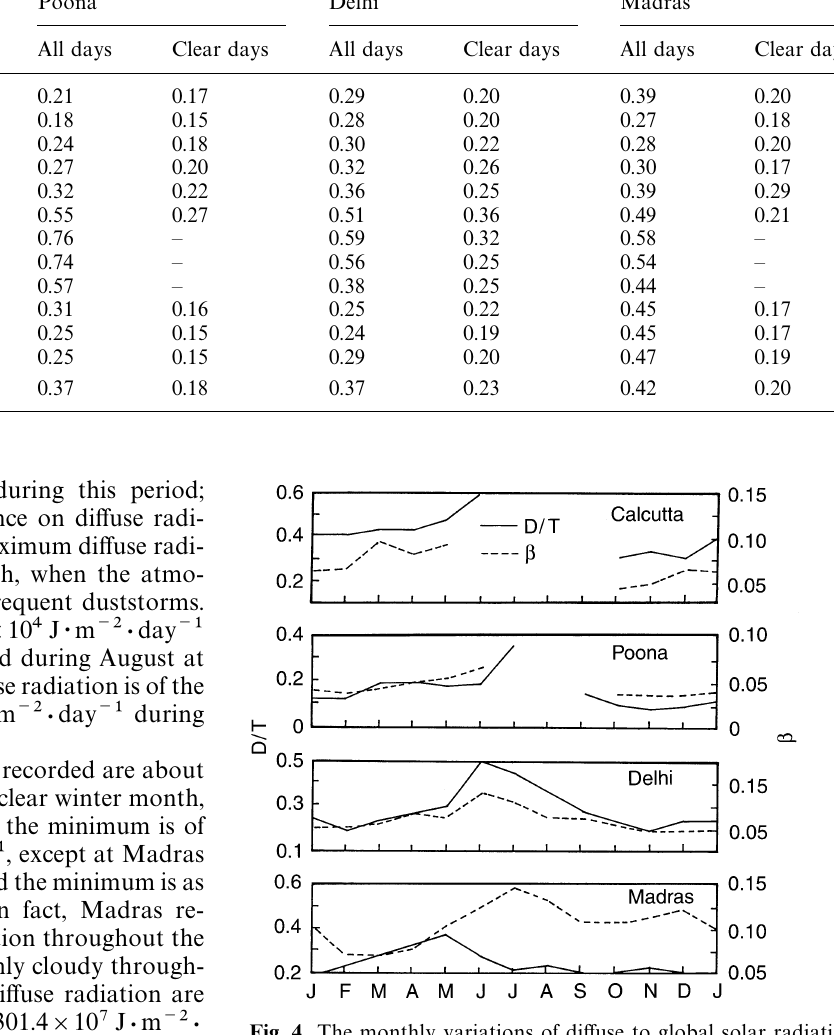
The mean daily values of the ratios of diffuse to global solar radiation ( D / „ ) for clear days and the mean daily values of the Angstrom turbidity coefficient ( (cid:98) ) for the four stations are plotted in Fig. 4. The coefficient (cid:98) is defined as the extinction due to scattering and absorption of aerosols. On a clear day one may expect D / „ to depend mainly on atmospheric turbidity. It is seen from Fig.